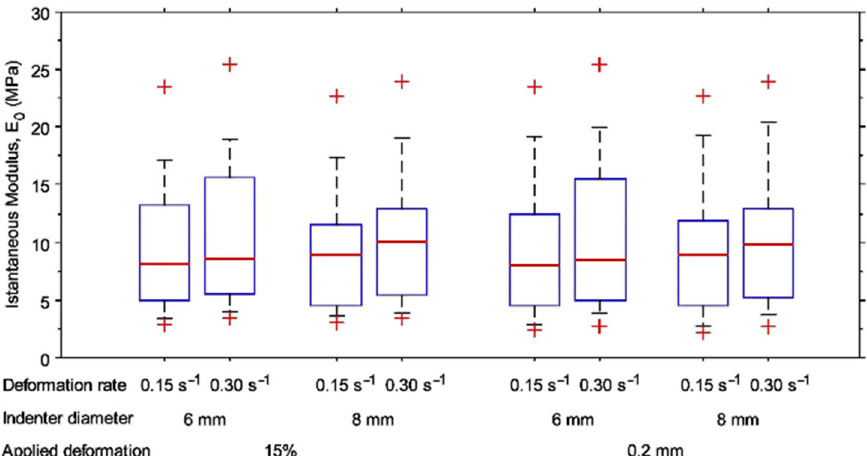
Figure 5. Box plots of E 0 15%def and E 0 0.20mm values determined using 6 mm and 8 mm indenters and of E 0 to indent the articular cartilage of the tibial plateau at two different deformation rates (0.15 s − 1 and 0.30 s − 1